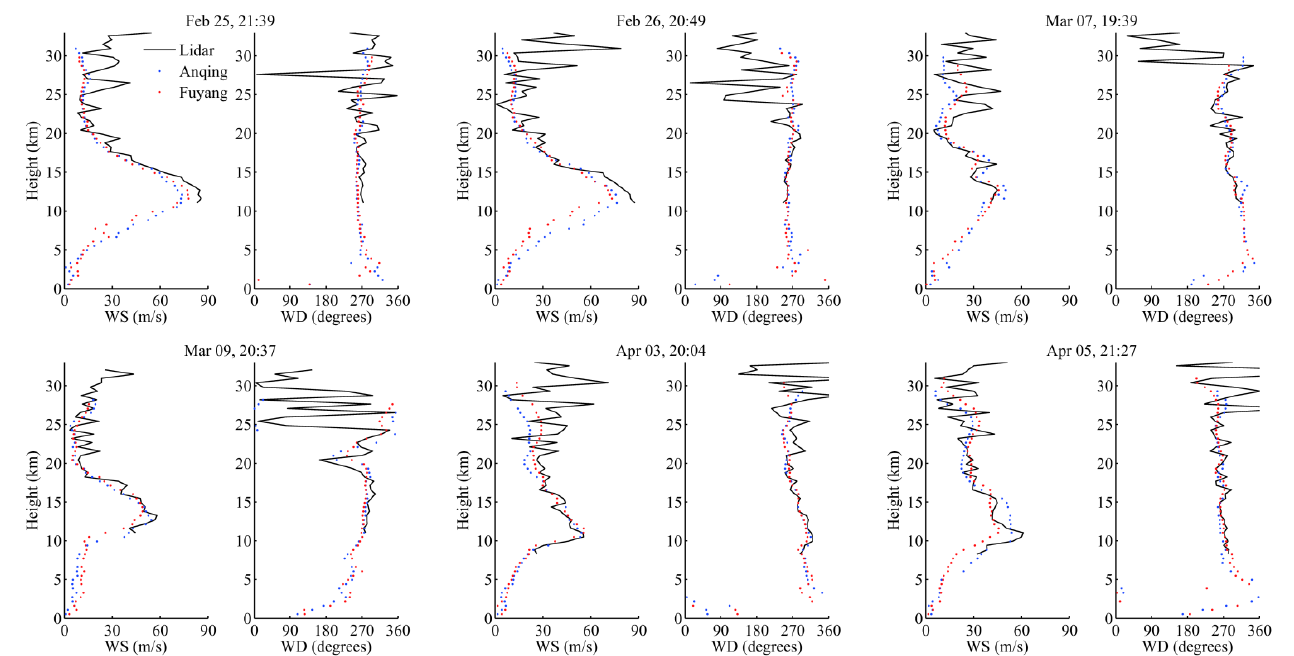
Figure 9. Comparison cases of wind speed and direction measured by lidar in Hefei (black lines) and radiosondes in Anqing (blue dots) and Fuyang (red dots).